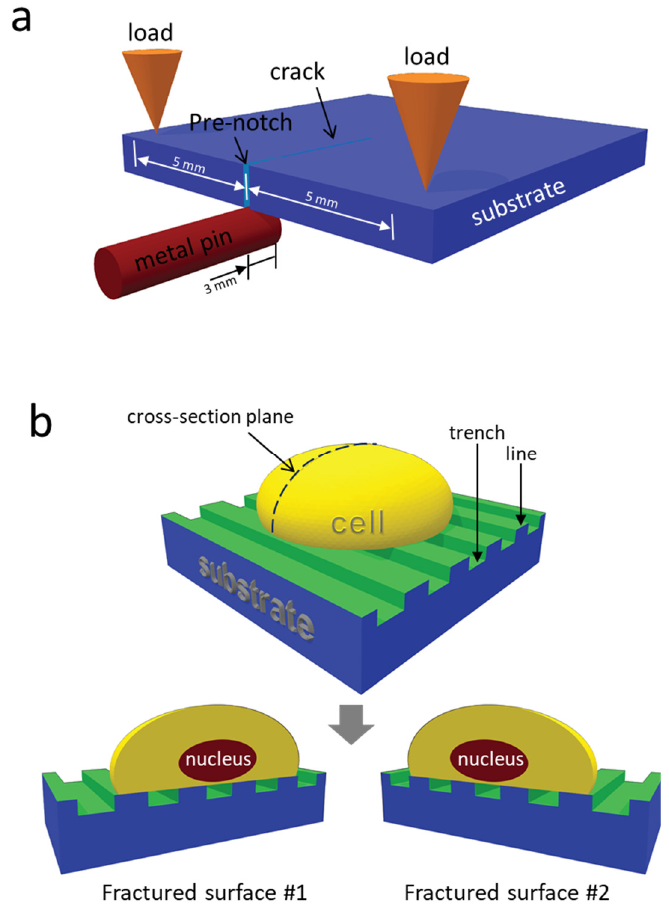
Figure 1. ( a ) Schematic drawing of the three-point bend micro-cleaving. ( b ) Cell dissection obtained using three-point bend technique. Substrate is covered with ~20 nm tantalum film (green).